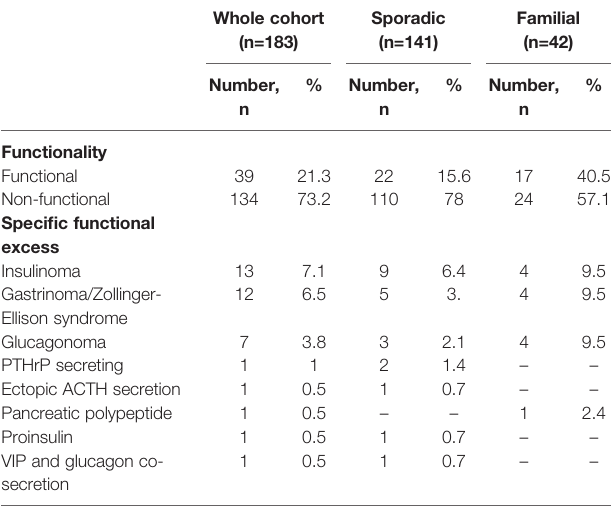
TABLE 2 | Functional hormone secretory patterns.